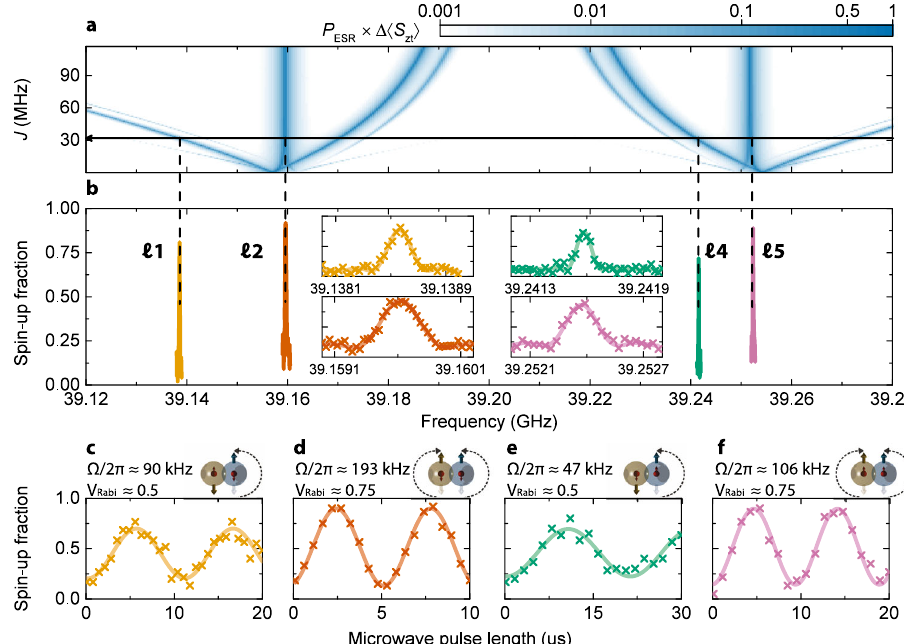
Fig. 5 Conditional and unconditional coherent control of the target qubit in the presence of an exchange-coupled control qubit. a Simulated evolution of the ESR spectrum as a function of exchange coupling J , using the system Hamiltonian (Eq. (1)) with parameters matching the experimental results. b Measured ESR spectrum of the target electron in the (1 c ,1 t ) charge region. The control electron is kept in the # (cid:3) (cid:3) (cid:4) state, while the four nuclear spin con fi gurations are deliberately initialized by nuclear magnetic resonance. All ESR peaks match the simulation by choosing the parameters J = 32.06±0.06MHz, A t = 97.75±0.07MHz, A c = 87.57±0.16 MHz, with maximum error Δ ℓ = 47.4kHz. c – f Target qubit Rabi oscillations measured on each of the resonances, ℓ 1 ( c ), ℓ 2 ( d ), ℓ 4 ( e ), and ℓ 5 ( f ). A π -pulse on ℓ 1 or ℓ 4 transitions constitutes a CROT two-qubit logic gate (Fig. 2b). The same microwave source output power (8dBm) has been used to drive all Rabi oscillations. The frequency Ω of the observed Rabi oscillations exhibits variations of up to a factor 4 between resonances, possibly due to a non-monotonic frequency response of the microwave transmission line. The visibility of the Rabi oscillations is systematically lower in the conditional resonances ( ℓ 1 and ℓ 4), as compared to the unconditional ones ( ℓ 2 and ℓ